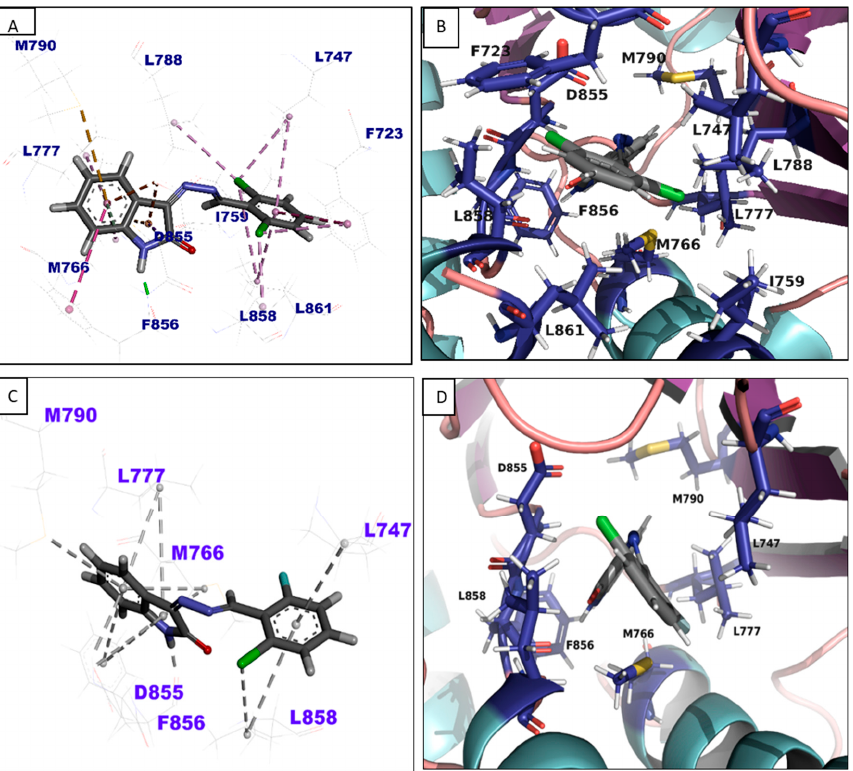
Figure 4. Docking pose of 1 and 2 within the active site of EGFR protein kinase: ( A ) 2D of 1 ; ( B ) 3D of 1 ; ( C ) 2D of 2 ; ( D ) 3D of 2 . Docking analysis of Compound 1 with VEGFR-2 kinase domain revealed 2 hydrogen